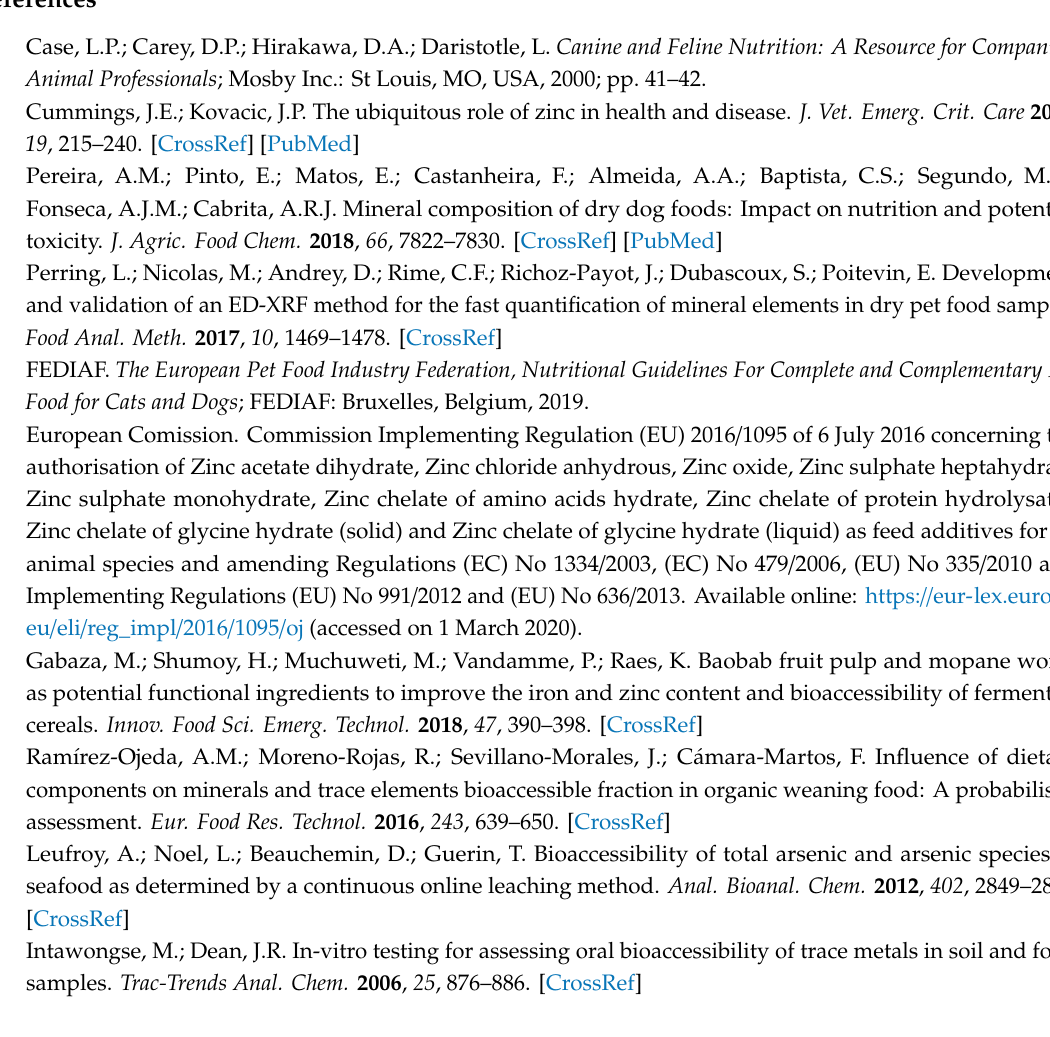
Supplementary Materials: The following are available online. Table S1. Main ingredients present on the tested dry dog food samples according to label information, Table S2. Total variance explained obtained by principal component analysis (PCA), Table S3. Component matrix obtained after the extraction method of the PCA, Table S4. Fraction collection time, fraction volume and total extraction volume for the extraction procedure, Figure S1. (a) Extraction chamber. A and D, polypropylene disk holder; B, O-ring; and C, Fluoropore ™ membrane filter (polytetrafluoroethylene) with a 1.0 µ m pore. (b) After the assembly of all parts, sample is placed inside the A moiety, through its wider opening, Figure S2. Kinetic profiles of bioaccessible Zn obtained for the dynamic extraction using flow rates of 0.5 mL min − 1 and 0.75 mL min − 1 , Figure S3. Comparison of the extraction profiles with and without pepsin, n = 2, Figure S4. Kinetic profiles of bioaccessible Zn obtained for all 14 samples, representing di ff erent types of market segment: (a) economic dry dog food, (b) medium type dry dog food, and (c) premium dry dog food, n = 2, Figure S5. Scree plot obtained by